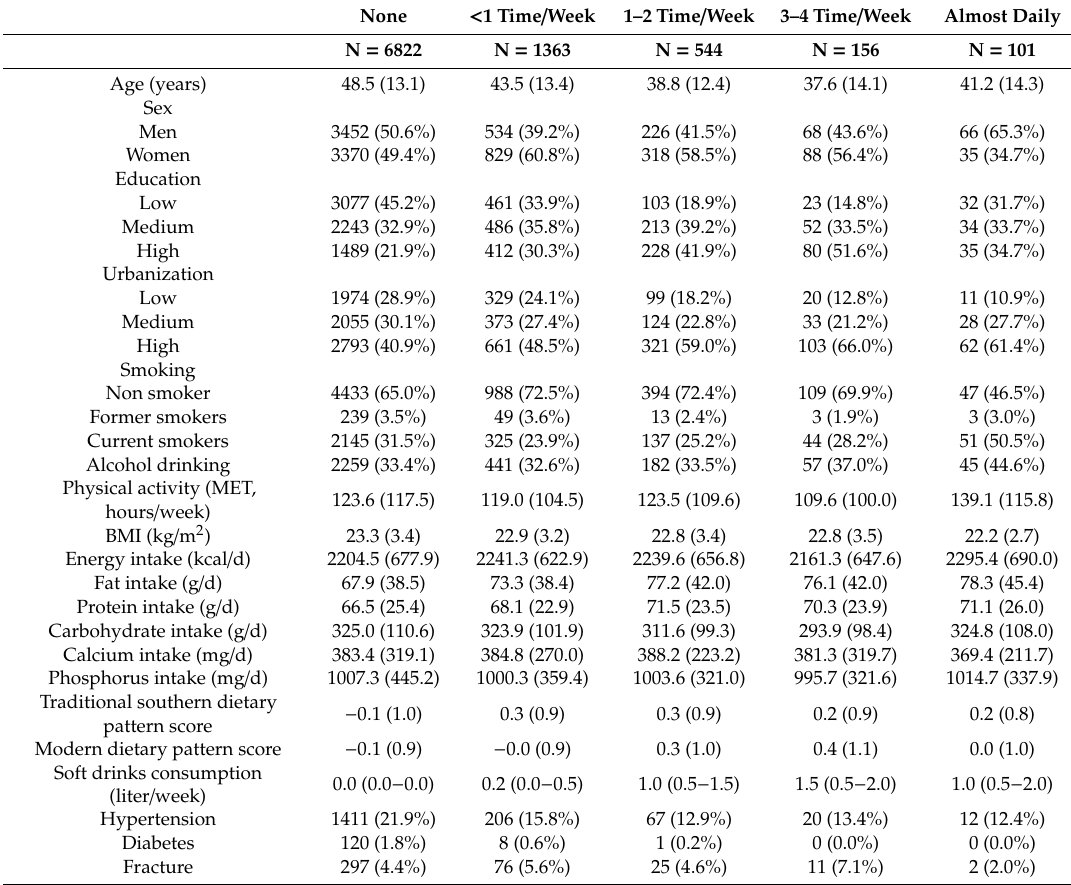
Table 1. Sample characteristics in 2004 by soft drinks consumption.